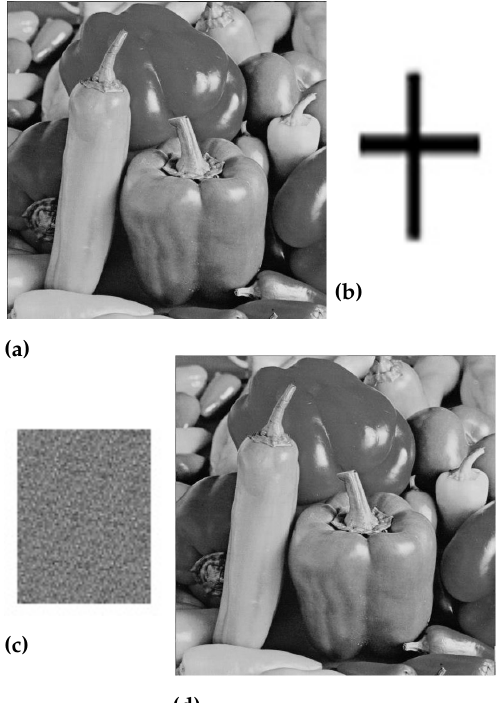
Figure 7. ( a ) Original peppers image, ( b ) Watermark image, ( c ) Scrambled image, and ( d ) Water- marked peppers image.